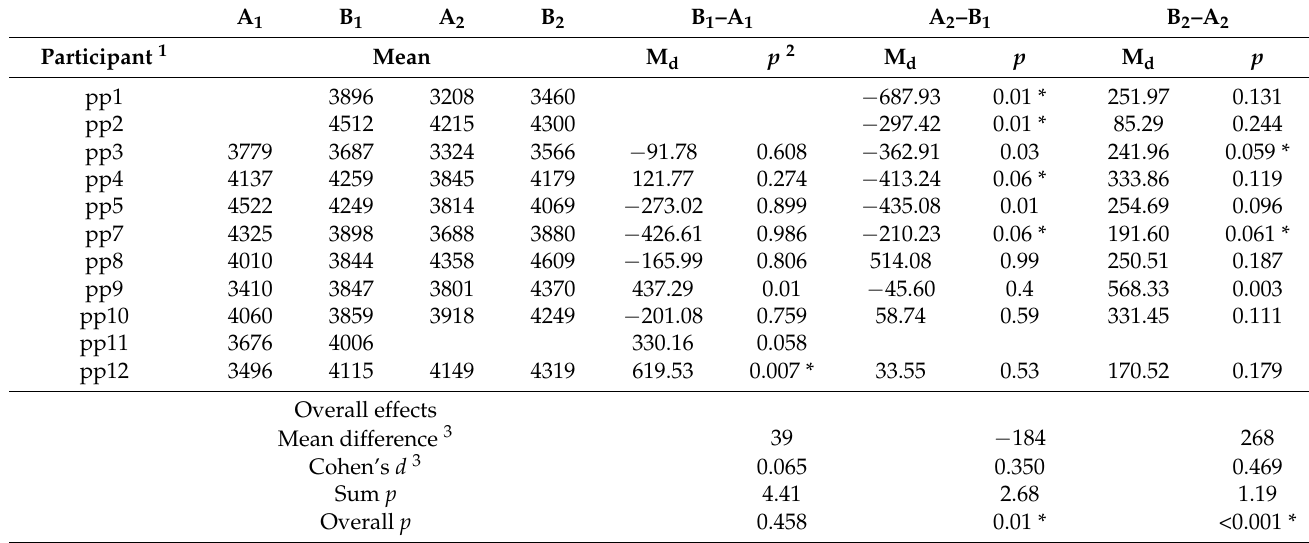
Table 5. Mean Kelvin values and mean differences and p -values for all